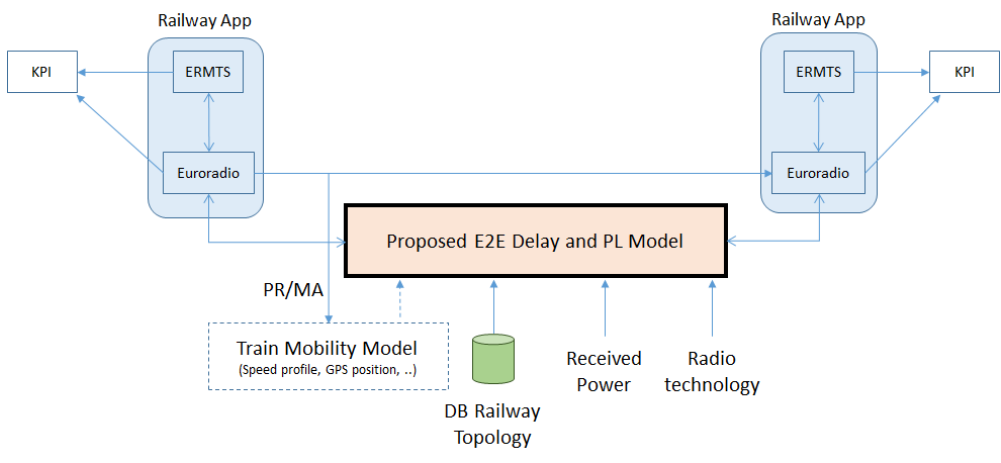
Figure 8. Principle scheme for the usage of the proposed model for performance